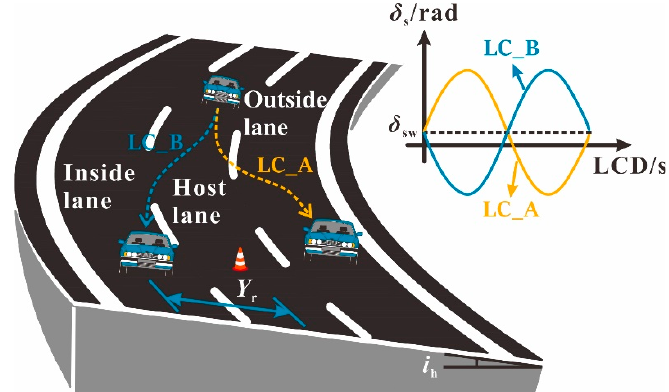
Figure 4. Lane changing